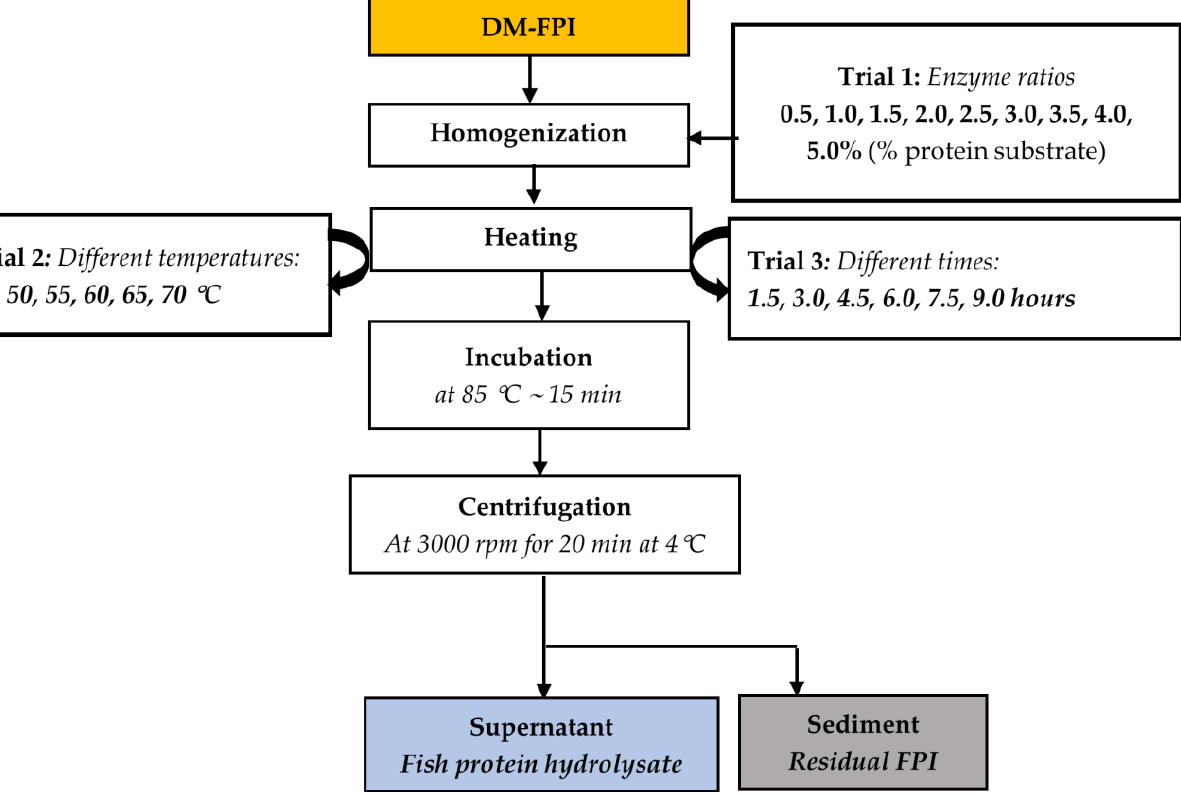
Figure 1. Experimental design for the optimization of FPH production from Tra catfish DM-FPI (dark muscle fish protein isolate) performed with three trials. Orange-filled box: protein, water-lipid, and ash content measured; blue-filled box: weight of the protein solution recorded and its protein content determined; grey-filled box: weight recorded and water content determined.